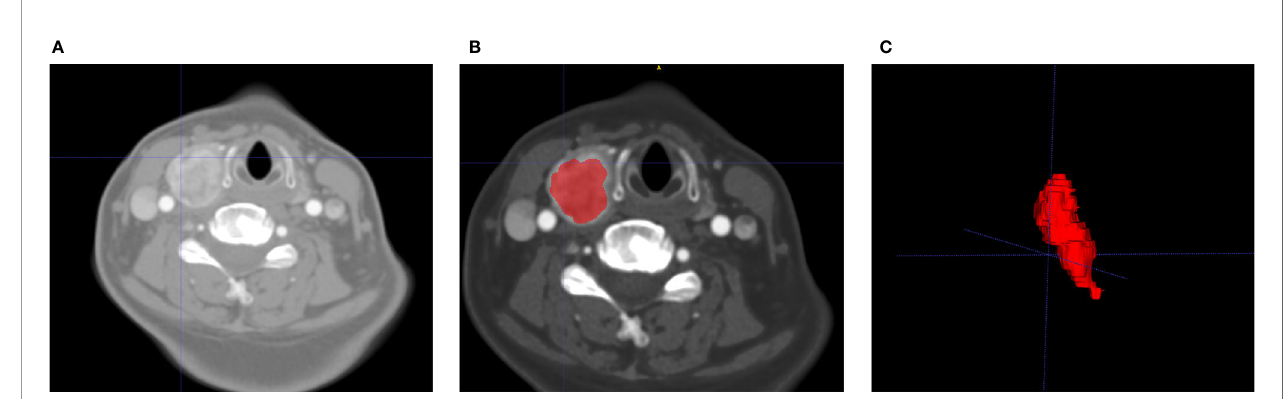
FIGURE 1 | Flowchart of the process of CT image segmentation and VOI construction. An example of primary tumor segmentation and VOI construction for patients with central lymph node metastasis. VOI segmentation is performed on unenhanced and contrast-enhanced computed tomography images (A) . Features are extracted from the VOI of primary tumor (B) , including tumor shape, intensity, and texture. The VOI of primary tumor can be shown in a 3D status (C) . VOI, volume